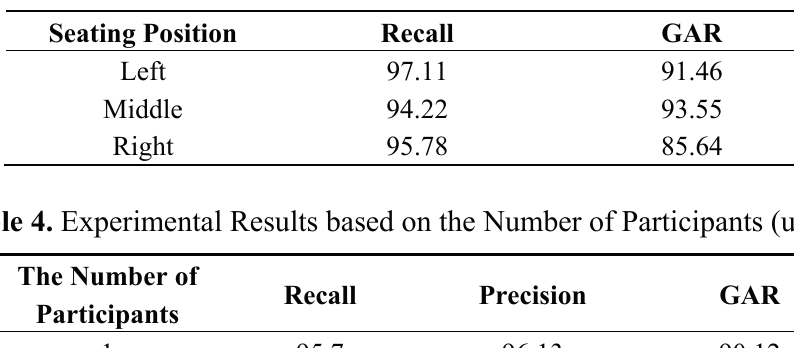
Table 3. Experimental Results based on Seating Positions (unit: %).